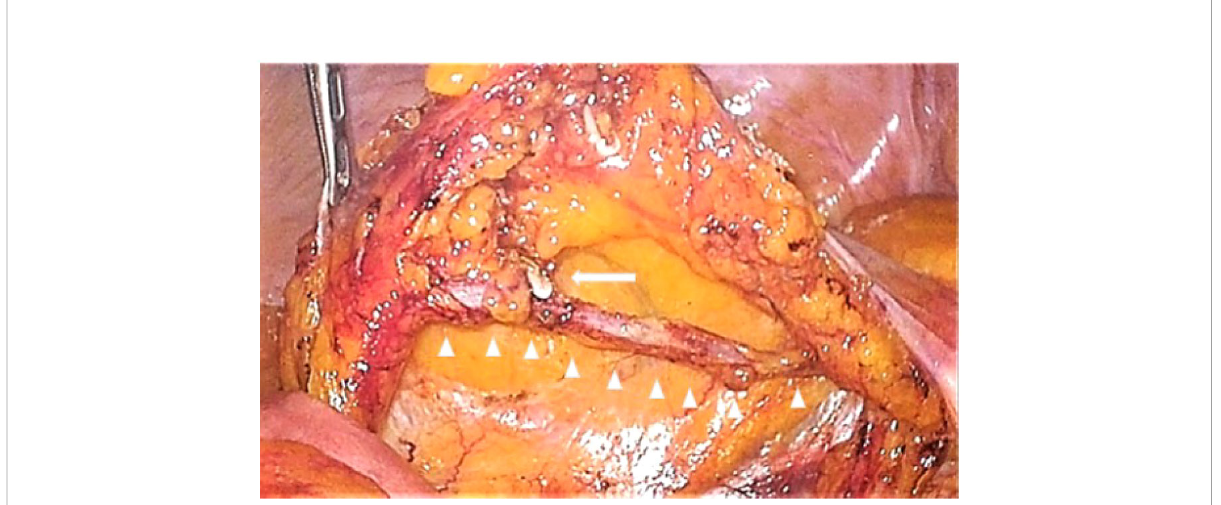
FIGURE 1 Preserved inferior mesenteric vein after dissection of lymph nodes around the inferior mesenteric vein. The left side of the fi gure is the cranial side, and the right side is the caudal side. The triangles indicate the skeletonized inferior mesenteric vein, and the arrow indicates the ligation of the left colic